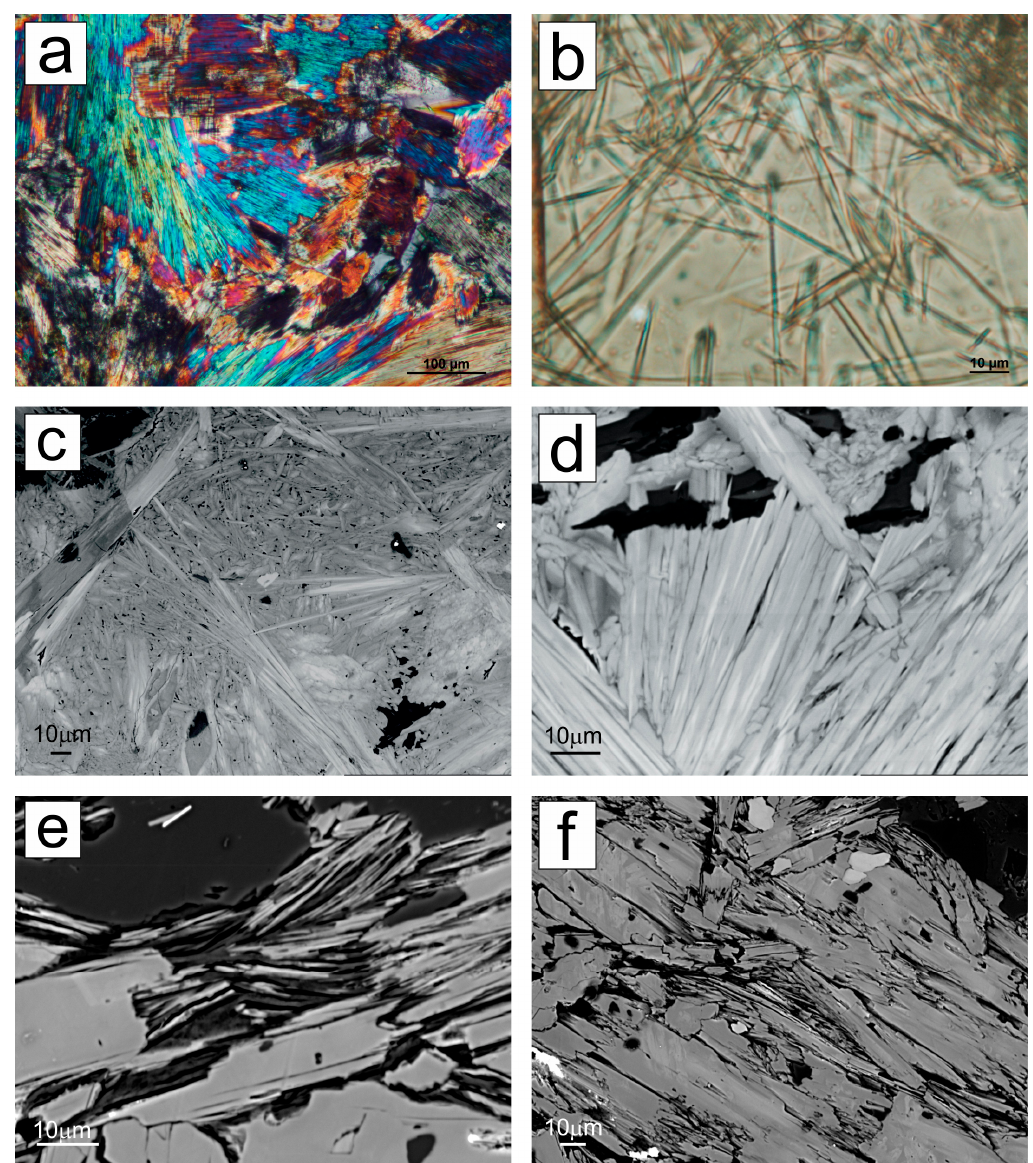
Figure 7. Thin section and back-scattered electron (BSE) images of the secondary amphibole in Isadalu magmatic rocks: ( a , b ) PLM images (crossed and parallel polarizers) of secondary amphibole pseudomorphosis; ( c , d ) BSE images showing geometry and morphology of secondary amphiboles; ( e , f ) BSE images of secondary amphibole with frayed ends showing acicular to fibrous aggregates morphology.